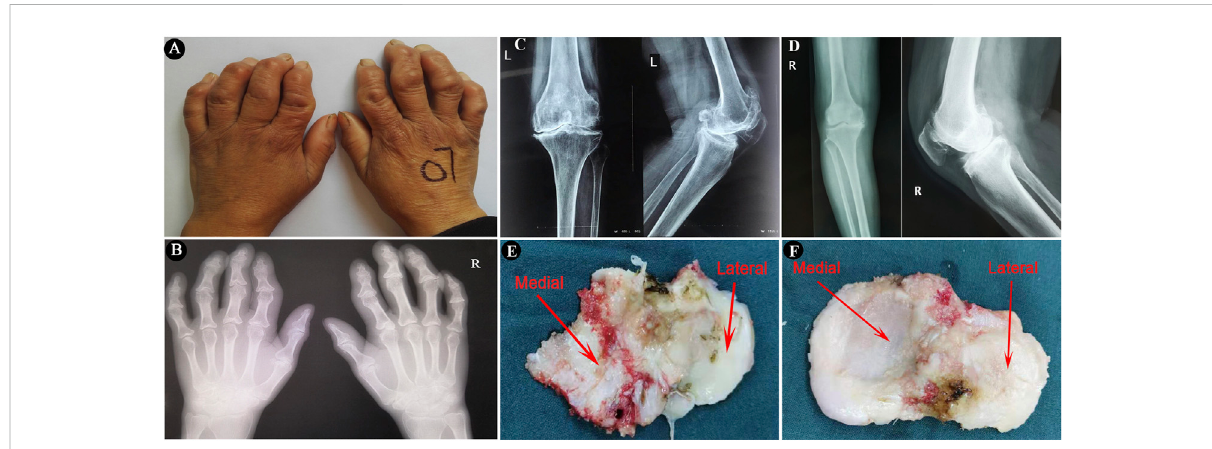
FIGURE 1 The imaging characteristics of the included subjects and surgically collected specimens. (A,B) , Images and radiographic images of bilateral handsofaKBDpatient,showingcrooked fi ngersandmetaphyseallesionsinthephalanges. (C,D) ,Radiographicimagesofanteroposteriorandlateral axial X-ray examination of knee joints of a KBD patient and an OA patient, respectively. (E,F) , Images of surgically collected specimens of tibial plateaus from a KBD patient and an OA patient,